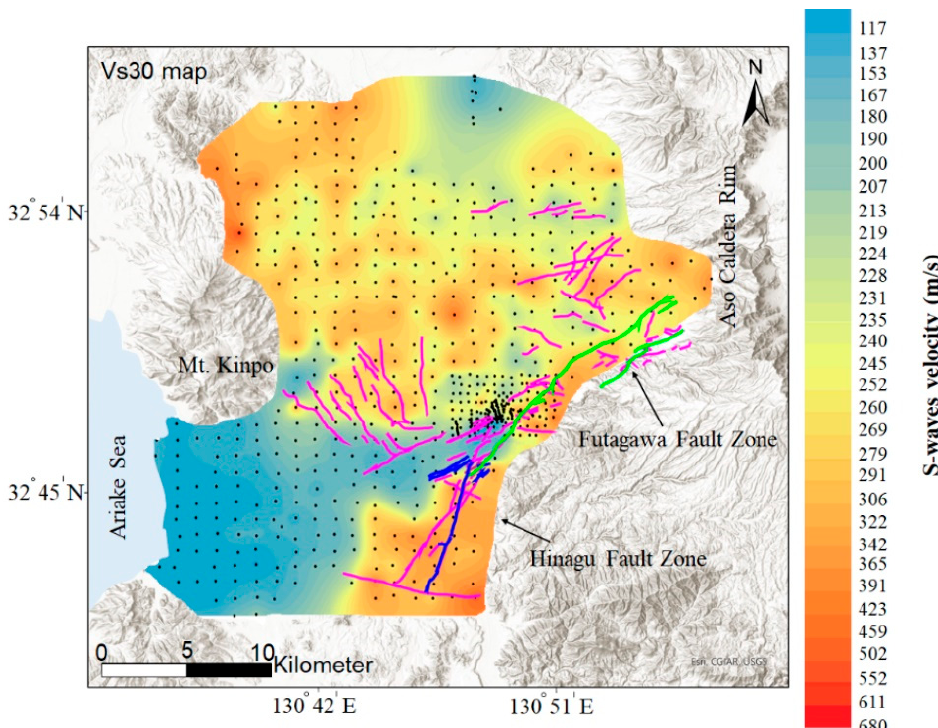
Figure 7. The average Vs for the upper 30 m of a soil profile. Black dots are Vs observation points, purple lines are linear surface ruptures mapped using InSAR by Fujiwara et al. [47], and the green and blue lines refer to Futagawa and Hinagu faults [77]. Background map is from ArcGIS ® software by Esri.